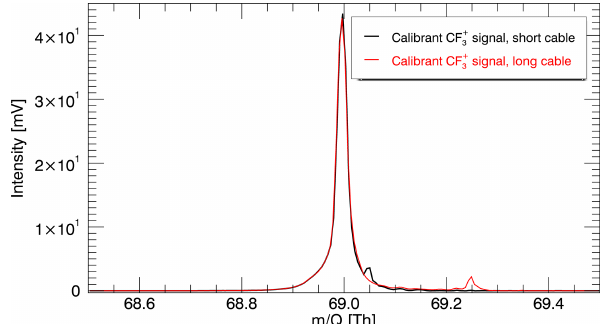
Figure 9. Comparison of CF 35 Cl + signals taken from the Figure 10. CF + signals obtained from the mass axis calibration 2 3 chromatographic peak apex of CFC-12. The solid lines in black substance (perfluoroperhydrophenanthrene; see also Sect. 2.3), with and red show intensities of a 0.1 and 1.0L sample, both signal intensity displayed on the y axis and m/Q displayed on from preconcentrations of the same reference gas. Towards high the x axis. The signal drawn in black was obtained with a short intensities (1.0L spectrum), a “shoulder” appears to the right of connection cable between MCP and pre-amplifier (ca. 150mm); the ion signal, which is not detectable at low intensities (0.1L the signal drawn in red was obtained with a long cable between spectrum). The blue dashed line shows the intensity of the 0.1L MCP and pre-amplifier (ca. 1500mm). No chromatographic run spectrum multiplied by 10 for comparison. No “shoulder” is visible was active at the time of recording. The signal elevation to the right in this calculated spectrum. of the actual ion signal is clearly shifted to the right if the signal travel time is increased by a longer